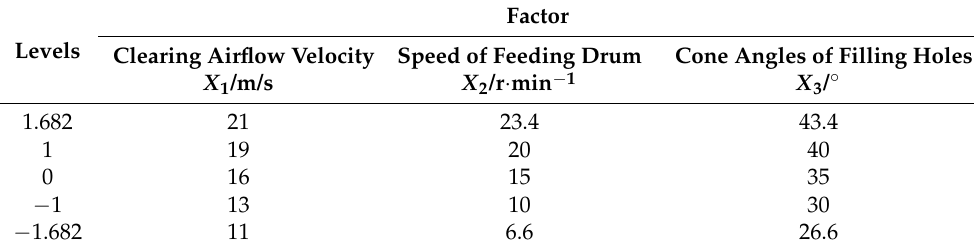
Table 1. Coding with factors and